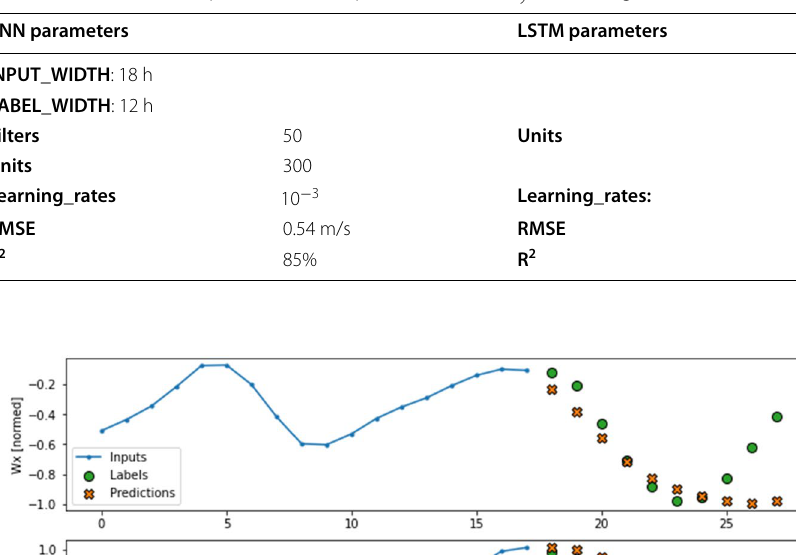
Table 3 CNN and LSTM parameters and performance for W y forecasting